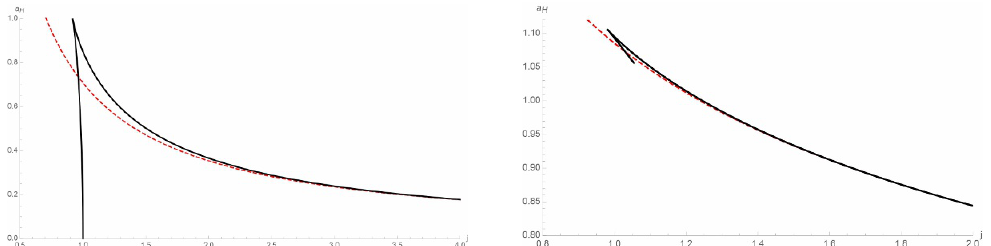
Figure 1 . On the left we show the reduced area a H as a function of the reduced angular momentum j for D = 5 where the black line is the exact curve of the black ring solution [27] and the dashed red curve is the blackfold approximation up to (cid:12)rst order in derivatives [28]. On the right we show the behaviour of the same quantities for black rings in D = 7 where the black line is the numerical solution of [29] and the dashed red line the blackfold approximation up to second order in derivatives